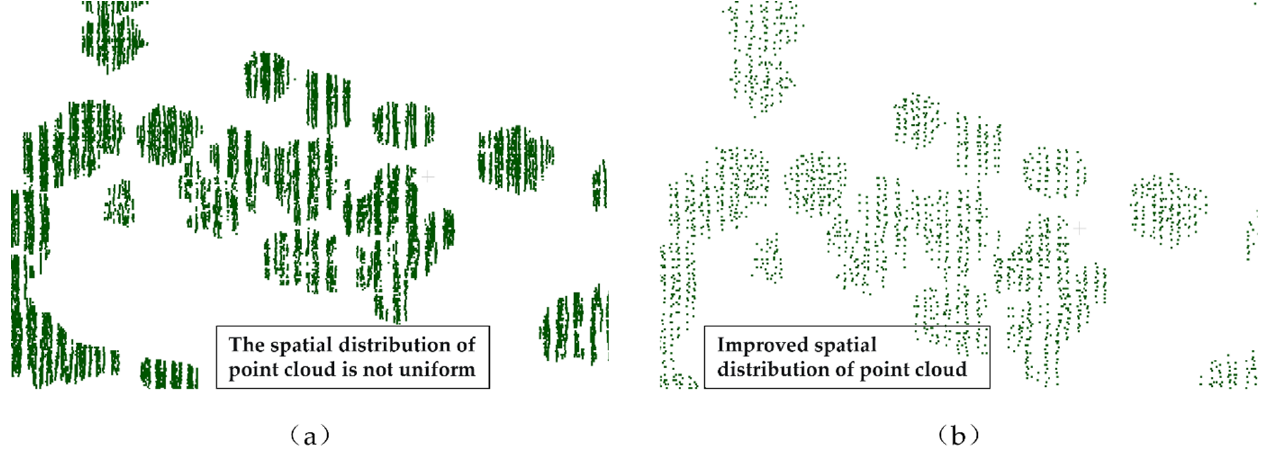
Figure 5. ( a ) Point cloud of trees before down-sampling (the gap between scan lines is too large). ( b ) Point cloud of trees after down-sampling (less affected by scan lines) . ( b ) Point cloud of trees after down-sampling (less affected by scan